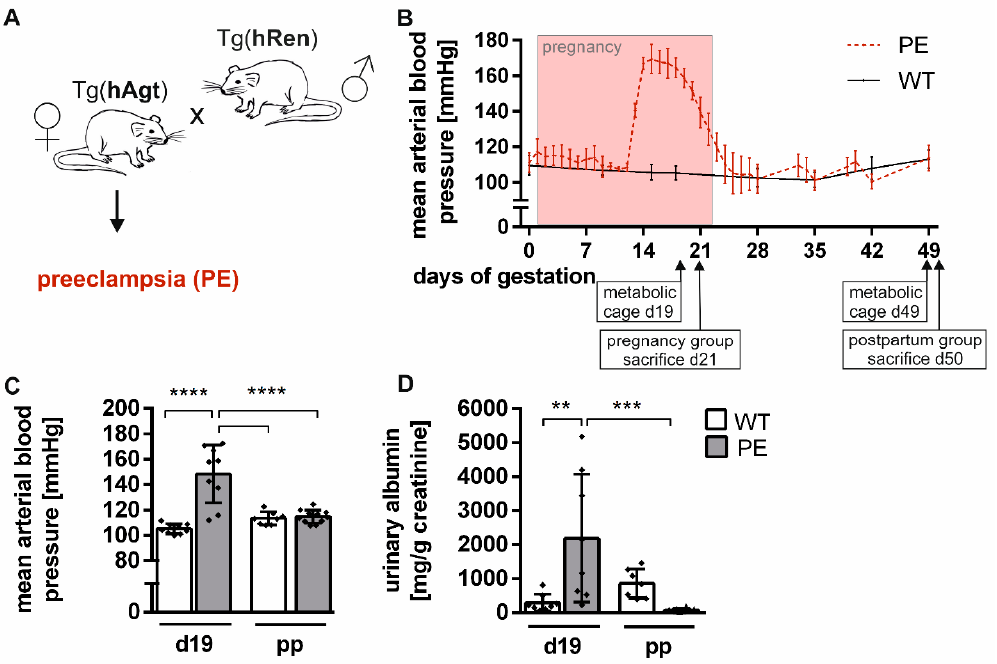
Figure 1. Hypertension developed during pregnancy in a preeclamptic rat model. ( A ) Female Sprague–Dawley rats transgenic for the human angiotensinogen gene (Tg(Agt)) were mated with male Sprague–Dawley rats transgenic for the human renin gene (Tg(Ren)). Thereafter, female rats developed a preeclamptic phenotype (PE). Sprague–Dawley wild-type rats (WT) were mated, and females served as a control. ( B ) Exemplary illustration of the course of the mean arterial blood pressure is shown for PE and WT over a period of 49 days, including pregnancy. It rose from day 12 to a maximum of 170 mmHg and recurred shortly after pregnancy in preeclamptic dams. Control rats did not develop hypertension. All values are presented as mean ± SD ( n = 5–9). Timepoints of metabolic cage and sacrifice are indicated. ( C ) PE rats developed hypertension during pregnancy, mean arterial blood pressure was significantly increased (day 19) compared to WT and recovered postpartum (day 49). ( D ) Albuminuria was detected as elevated urine albumin to creatinine ratio ( n = 8) in preeclamptic rats during (day 19) and after pregnancy (day 49) compared to pregnant WT. A statistical analysis was not conducted for the course of blood pressure. Statistical analysis was performed using a two-way ANOVA. Bars are shown as mean ± SD ( n = 8–11). p -value is shown as ** p ≤ 0.01; *** p ≤ 0.001; **** p ≤ 0.001 (between groups).